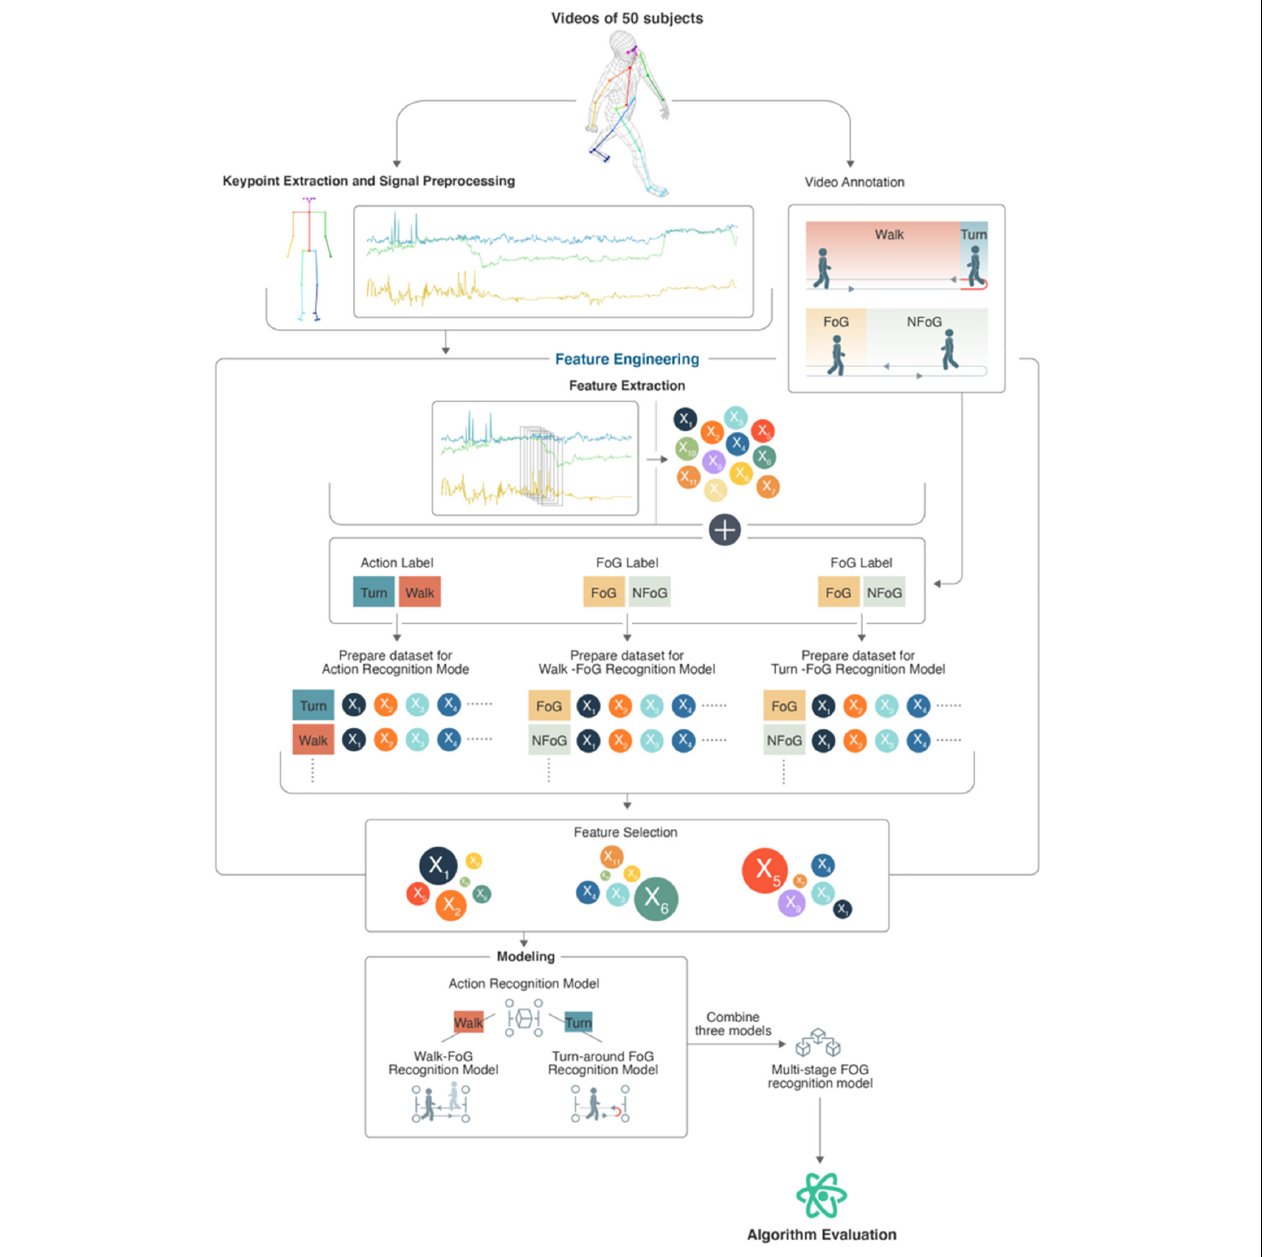
FIGURE 2 | Algorithm